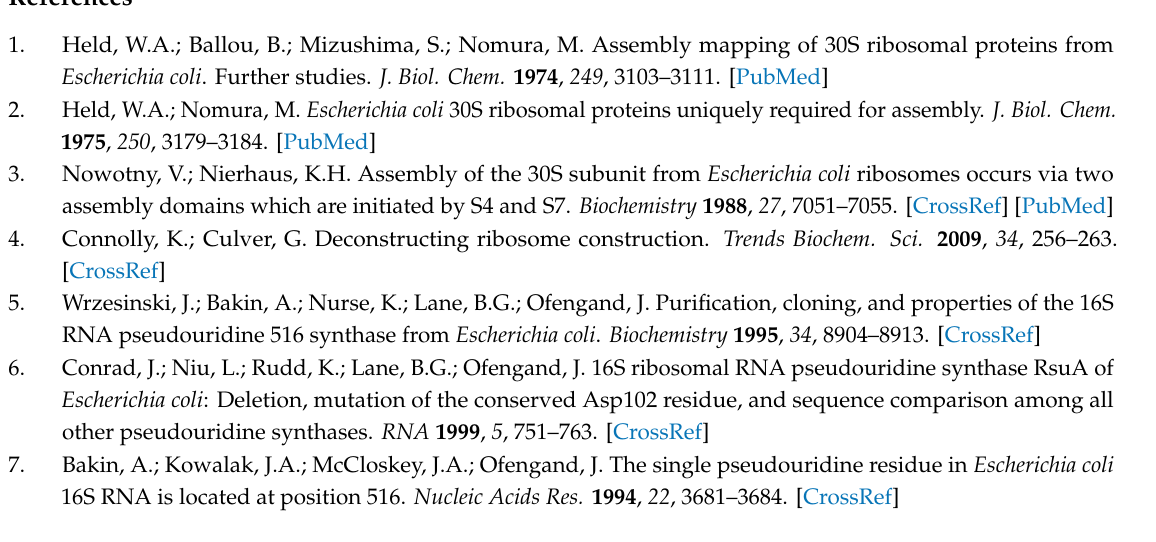
Figure S1: SDS-PAGE analysis of purified and fluorescently labeled RsuA protein, Figure S2: SDS-PAGE analysis of purified ribosomal proteins, Figure S3: Pseudouridylation activity assay for